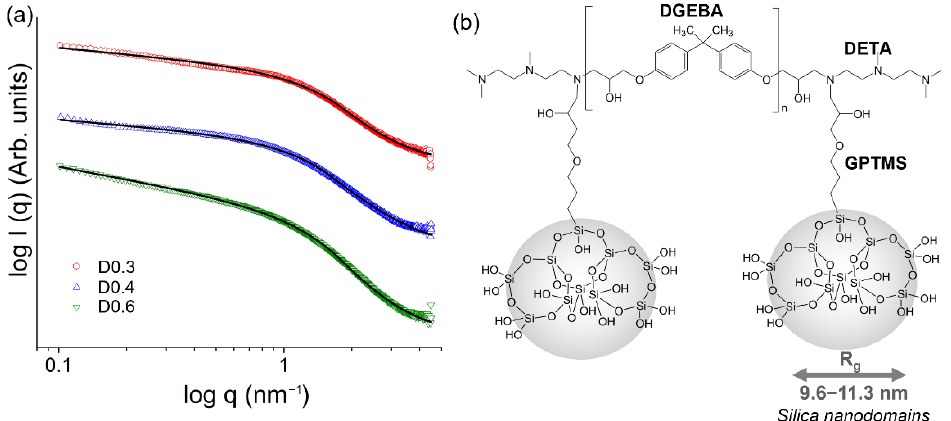
Figure 2. ( a ) SAXS scattering profiles of epoxy – silica hybrids prepared with different proportions of curing agent (DETA) fitted according to the Guinier – Porod model (black lines), ( b ) Structural representation of epoxy – silica hybrids. Table 3. Properties of the epoxy – silica hybrids: Porod exponent ( α ), dimension shape variable ( s ); and gyration radius ( R g ) determined by SAXS; adhesion strength to the steel substrate measured by pull-off test; surface roughness ( R RMS ) extracted by AFM; water contact angle; film thickness obtained by optical interferometry; porosity percentage obtained by pycnometry.